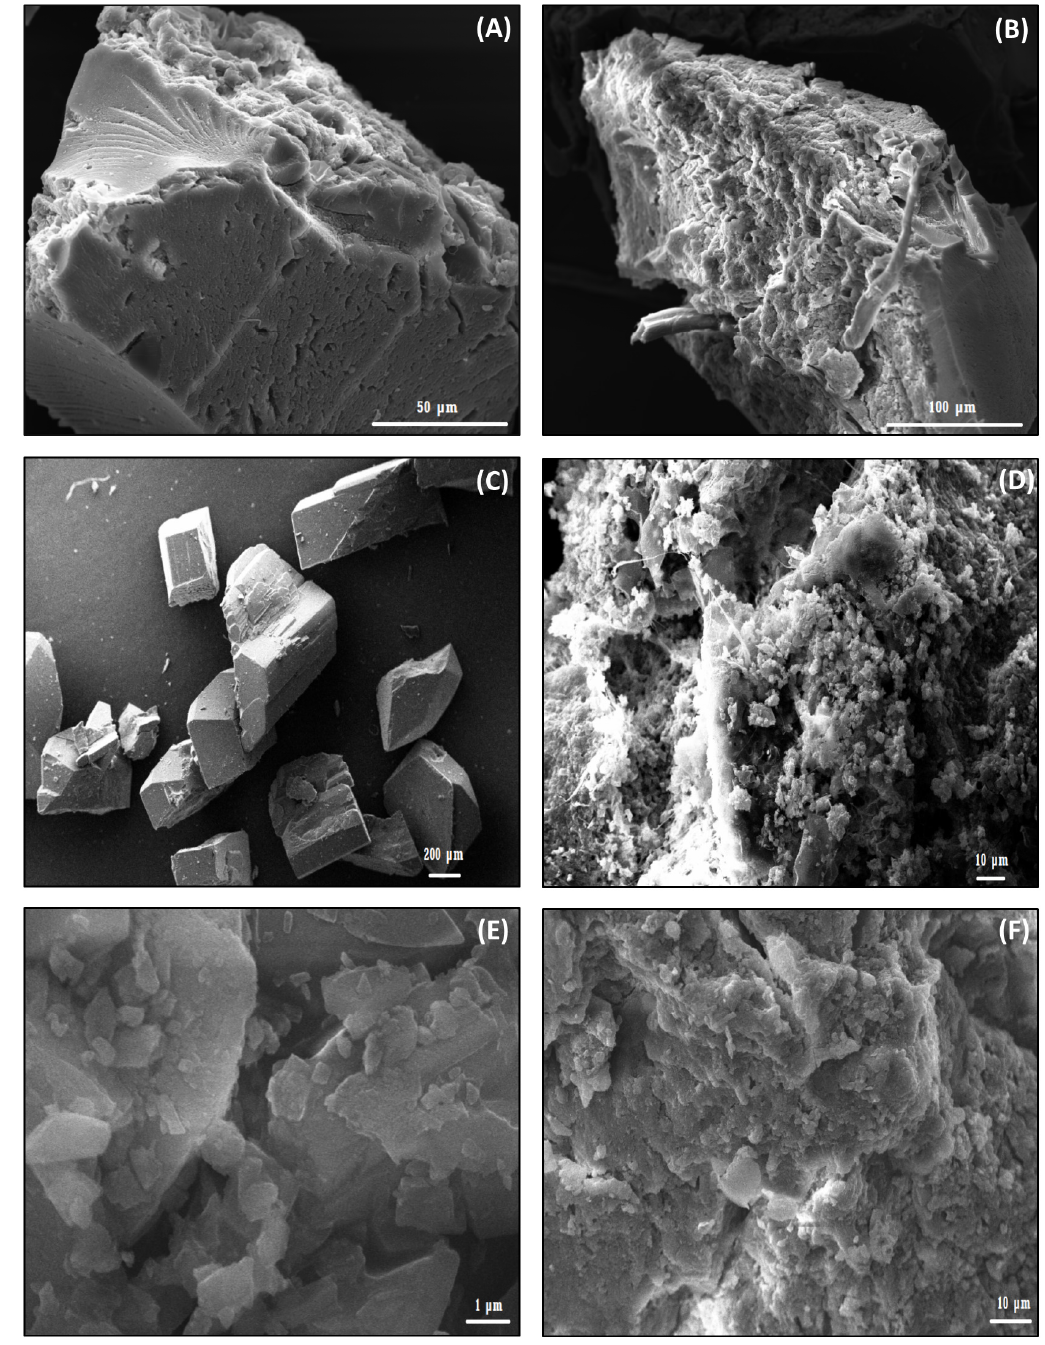
Figure 5. FE-SEM images of NSs ( A , B ), MPH ( C ), NSs–MPH ( D ), CUR ( E ), and NSs–CUR ( F ).